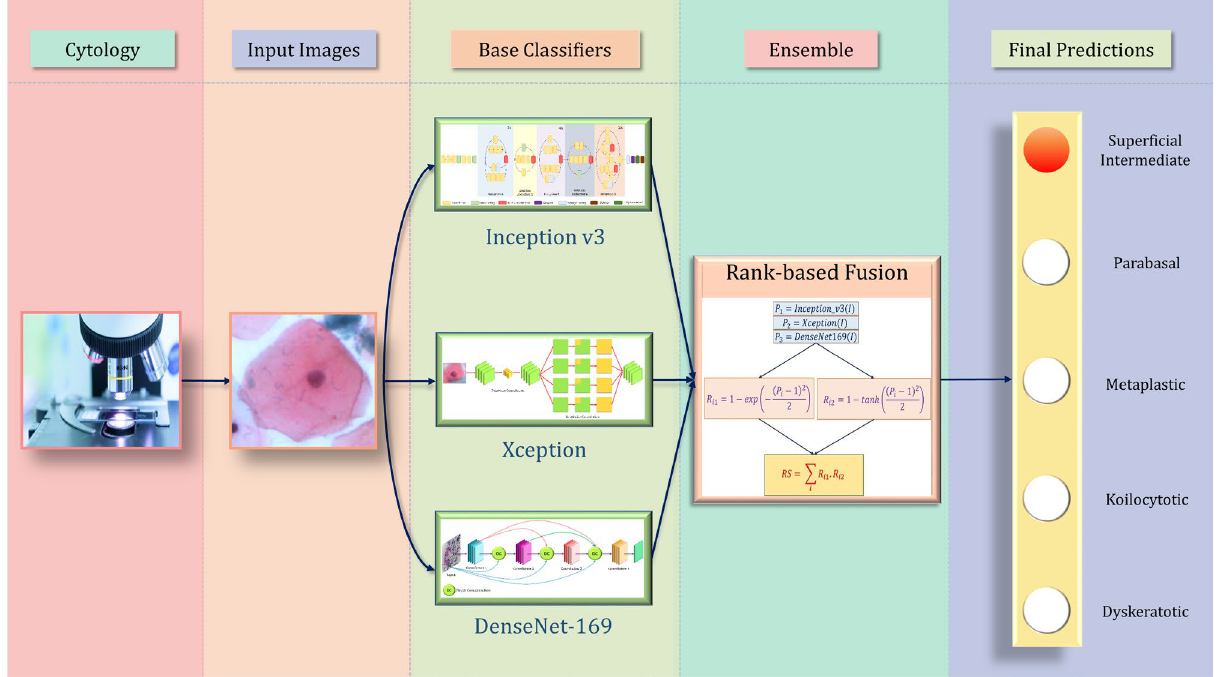
Figure 1. Overall structure of the proposed fuzzy rank-based ensemble of CNN models used for classification of cervical cytology (the image of the microscope under “Cytology” has been taken from the website (open- access) by Marsh et al. 8 , and the pap stained image under “Input Images” has been taken from the publicly available SIPaKMeD Pap Smear dataset 9 used in this research and the complete image has been made by R.K. using Google